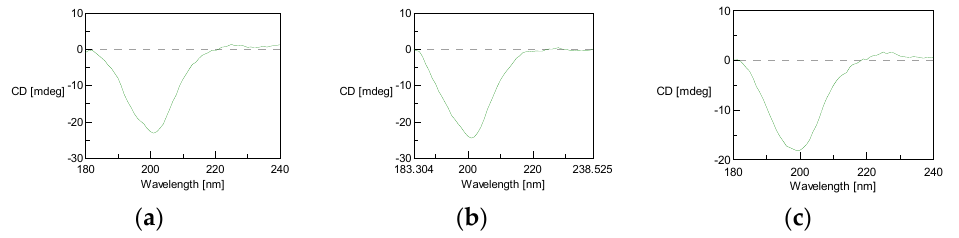
Figure 8. Circular Dichroism (CD) spectra of F1, F2, and F3 ( a , b , and c , respectively) fractions of collagen from hake skin measured at 18 °C.